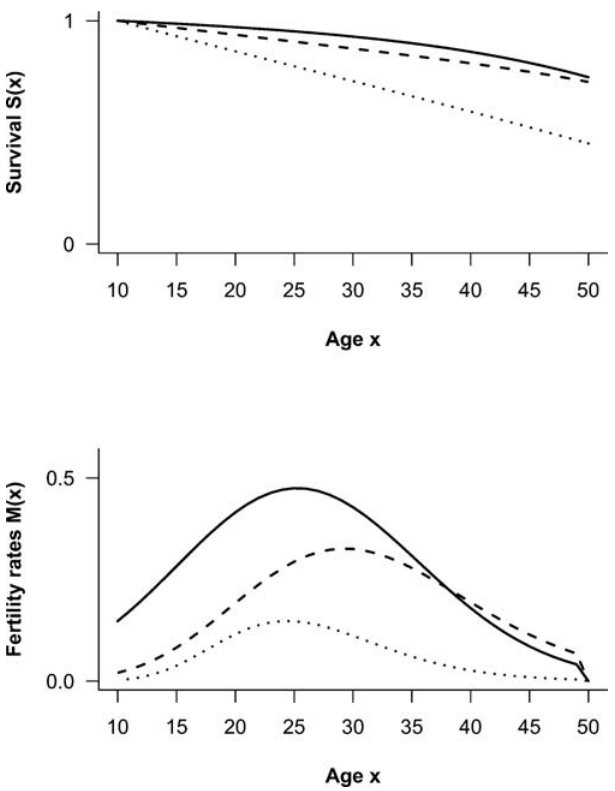
Figure 2. Demographic scenarios. Adult women’s survival (A) and fertility (B) from ages 10 to 50 for the population of early Quebec (solid line), the Ache (dashed line) and the modeled population (dotted line). These populations differ by their growth (respectively high, interme- diate and stationary, see [12,13,14]). Female adults’ age-specific survivals were modeled by a Gompertz-Makeham. For Quebec, a =4.69 6 10 2 4 , b =7.28 6 10 2 2 , D =0 and c =1.49 6 10 2 3 . For the Ache, a =3.00 6 10 2 5 , b = 1.10 6 10 2 1 , D = 0 and c = 6.33 6 10 2 3 . For the modeled population, a = 1.99 6 10 2 3 , b = 5.82 6 10 2 2 , D = 10 and c =1.2 6 10 2 2 . Female adults’ fertilities were modeled by a Hadwiger function. For Quebec, TFR =12.25, h 1 = 2 246.92, h 2 =18.72, h 3 =272.77. For the Ache, TFR =8.032, h 1 = 2 36.82, h 2 =4.79, h 3 =68.29. For the modeled population TFR =2.578, h 1 = 2 7.61, h 2 =3.31, h 3 =34.31.